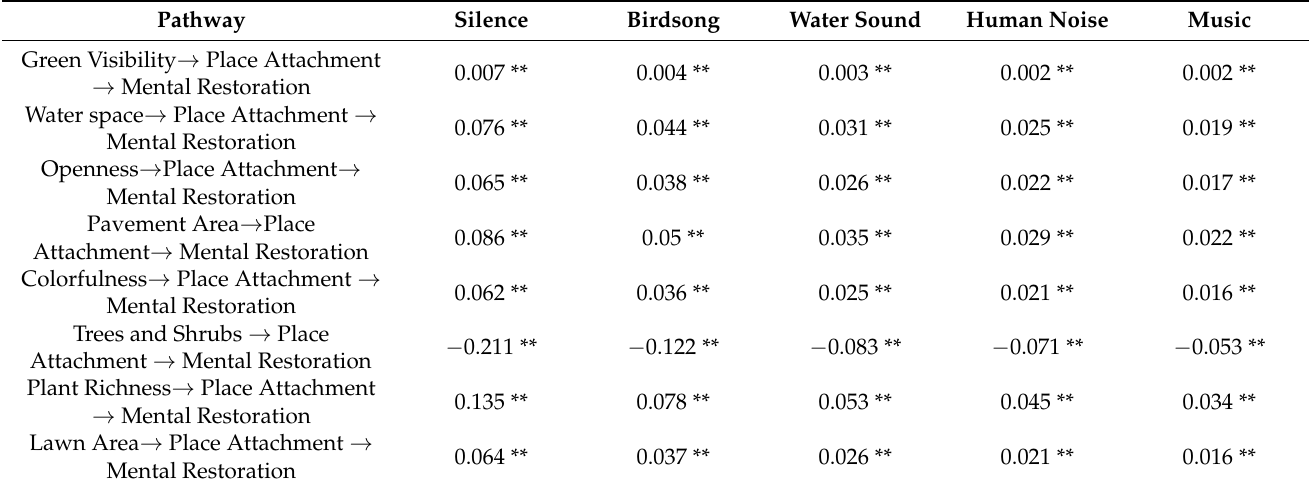
Table 6. Standardized indirect effects of environmental characteristic on mental restoration (** p <